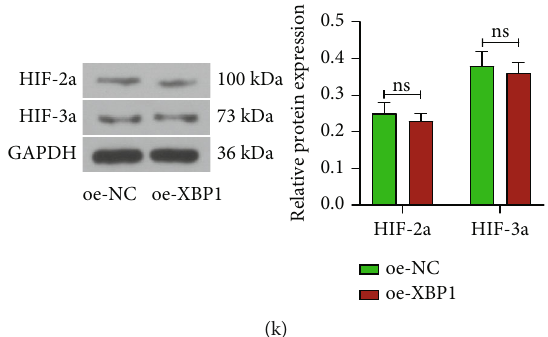
Figure 3: XBP1 promotes the expression of HIF-1a. (a) HIF-1a was predicted as a downstream gene of XBP1 in the hTFtarget database. (b) Potential binding sites of the HIF-1a promoter to XBP1. (c) RT-qPCR analysis of HIF-1a expression in nasal mucosal tissues from CRSsNP patients and controls. (d) RT-qPCR analysis of HIF-1a expression in nasal mucosal tissues from CRSsNP mice and controls. (e) RT-qPCR and (f) Western blot analyses of XBP1 mRNA and protein expression in mice. (g) Detection of mRNA expression of XBP1 and HIF-1a in cells by RT-qPCR. (h) The enrichment ability of anti-XBP1 on HIF-1a promoter assessed using ChIP-qPCR. (i) The e ff ect of overexpression of XBP1 on promoter luciferase activity of HIF-1a measured using dual-luciferase assay. (j) The e ff ect of overexpression of XBP1 on HIF-2a and HIF-3a mRNA expression by RT-qPCR assay. (k) The e ff ect of overexpression of XBP1 on HIF-2a and HIF-3a protein expression by Western blot assay. ∗ p < 0 : 05 and ∗∗ p < 0 : 01 versus the CRSsNP mice administrated with sh-NC or HNEPC transfected with oe-NC. The data are measurement data, presented as mean ± SD . Data between two groups were compared using an unpaired t test. Data among multiple groups were compared using two-way analysis of variance and then analyzed with Tukey ’ s post hoc test. The experiment was independently repeated three times. n = 6